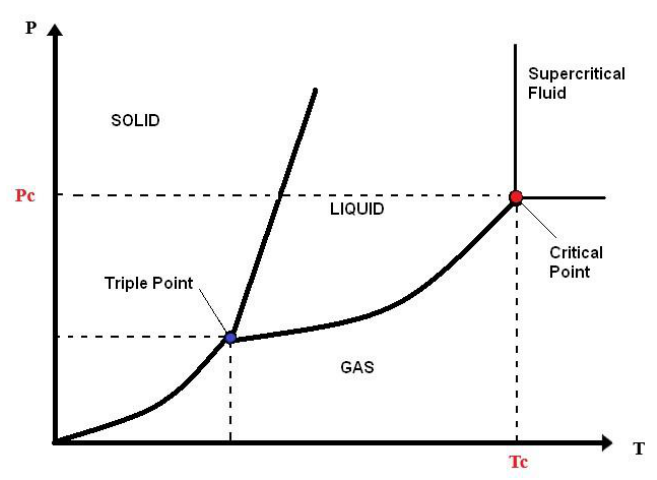
Figure 3. Schematic diagram phase of water.